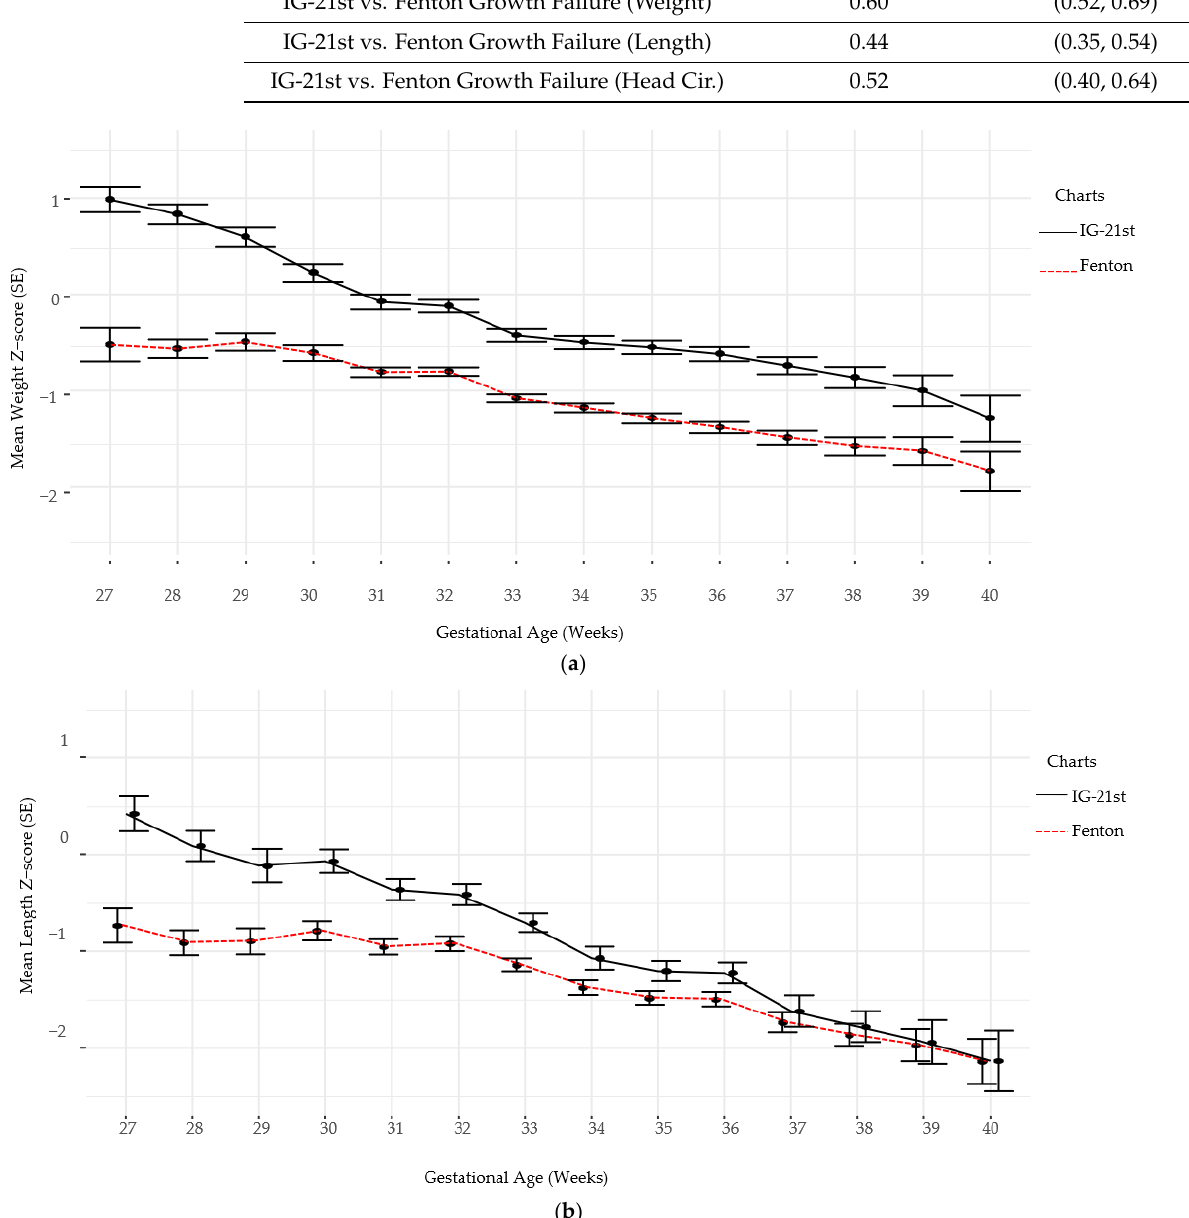
Figure 2. ( a ) Weight Z-scores by gestational age by chart. ( b ) Length Z-scores by gestational age by chart. The unadjusted logistic regressions (Table 4) between weight-based growth failure for each tool and each of the neurodevelopmental outcomes imply that IG-21st growth failure may be a significant predictor of a poor language development ( p = 0.094). It is